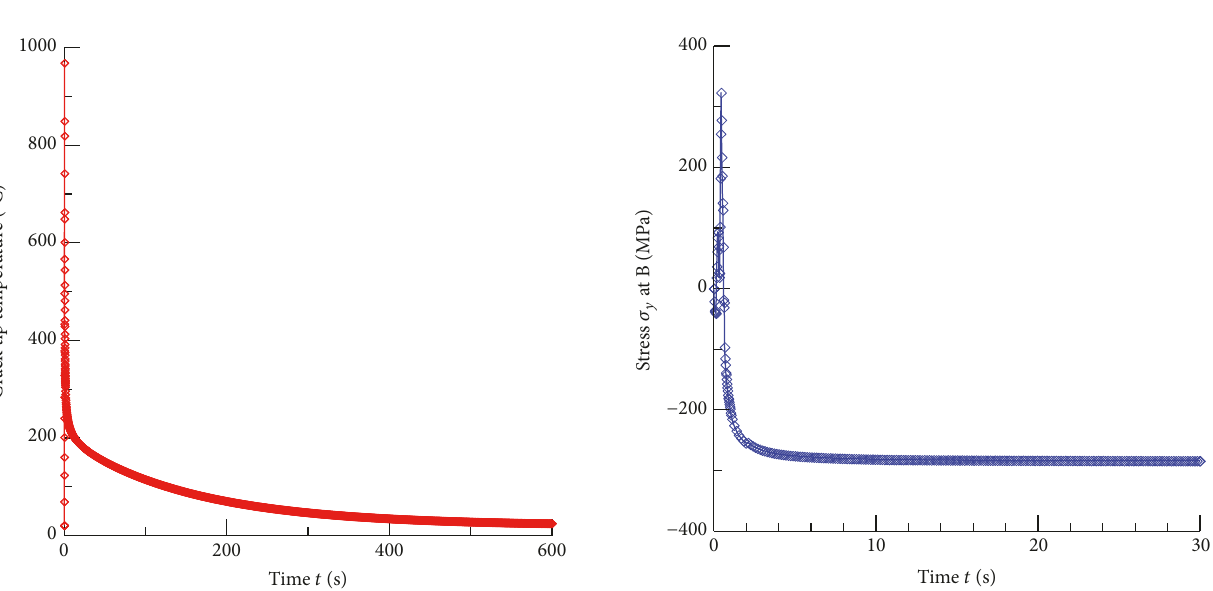
Figure 7: Time-history of crack tip temperature ( 𝑡 = 0 ∼ 600 s).